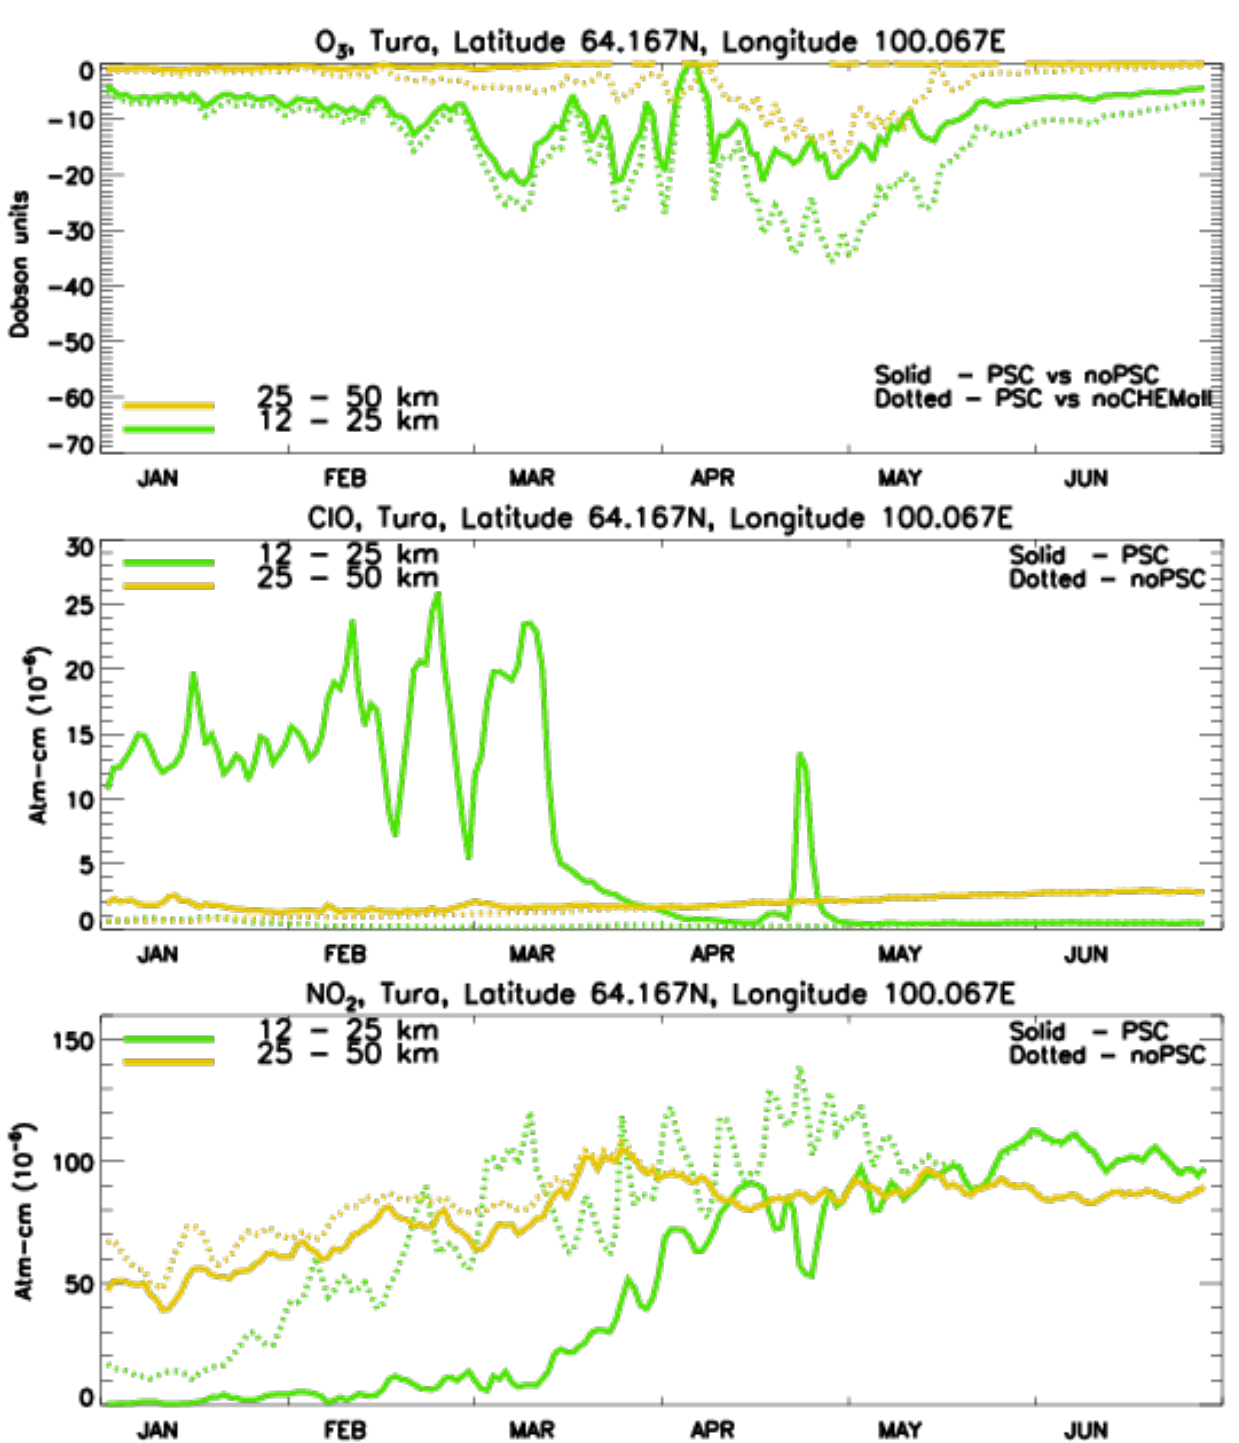
Figure 16. Tura station values estimated with the CTM for the lower stratosphere (green) and the upper stratosphere (yellow): ( top ), the difference in ozone content for the scenarios PSC and noPSC (solid) and PSC, and PSC and noCHEM (dotted), chlorine monoxide ( middle ), and nitrogen dioxide ( bottom ) for the PSC (solid) and noPSC (dots).